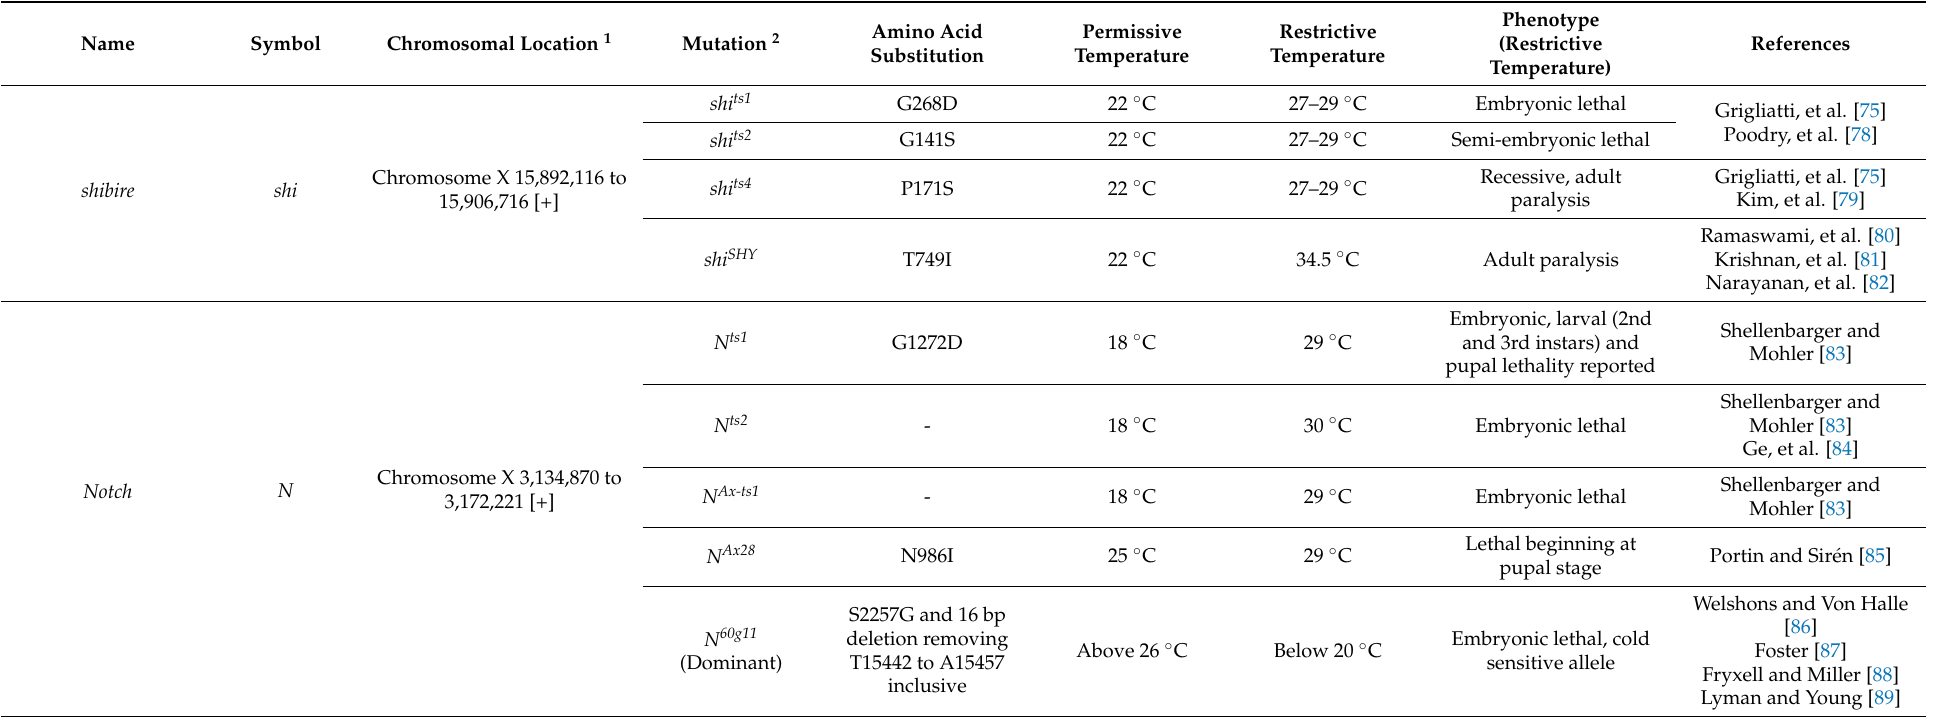
Table 1. Characterised Drosophila melanogaster temperature sensitive mutations with potential to cause embryonic lethality if introduced into other insect